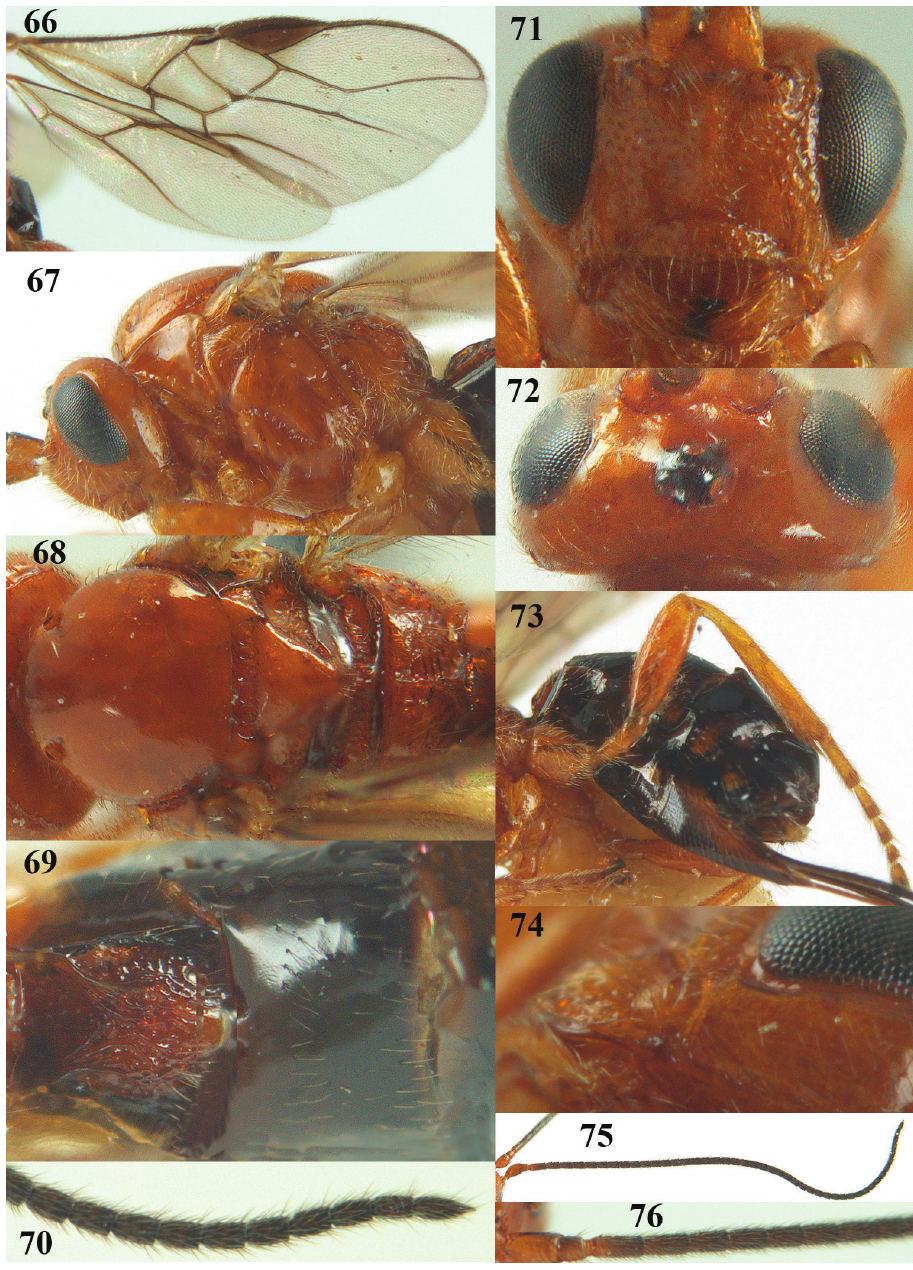
Figures 66–76. Psyttalia romani (Fahringer), ♀ , Russia, Novorossijka. 66 wings 67 head and mesosoma lateral 68 mesosoma dorsal 69 first–third metasomal tergites dorsal 70 apex of antenna 71 head anterior 72 head dorsal 73 hind leg and hypopygium lateral 74 mandible lateral 75 antenna 76 base of